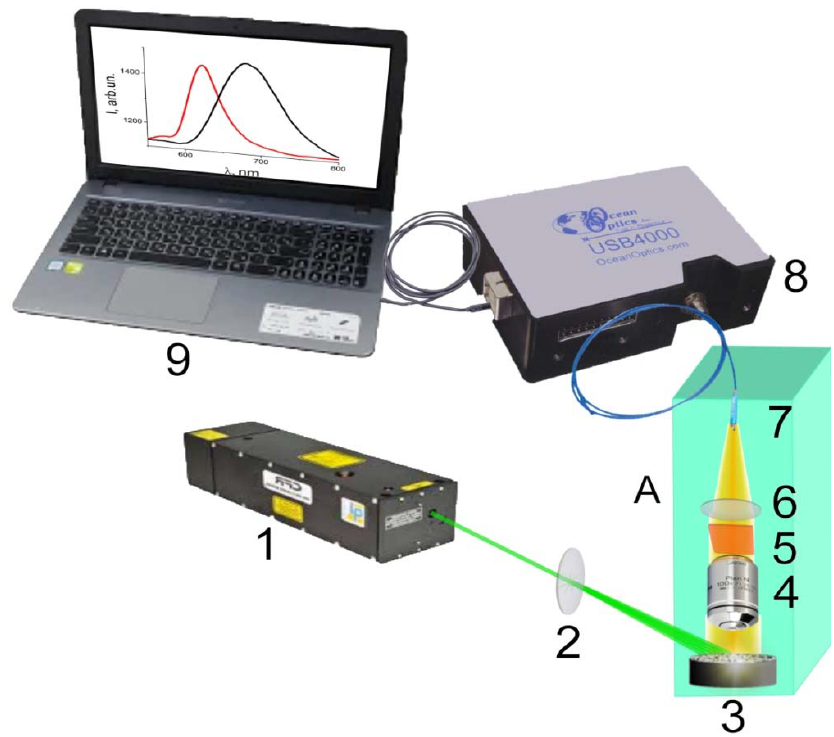
Figure 1. The scheme of the band-limited reference-free speckle spectroscopy (BLRFS) instrument used in this work: 1—a continuous wave (CW) pumping laser; 2—a concave lens; 3—a probed sample (a fluorescent dye-doped layer consisting of TiO2 or SiO2 nanoparticles); 4—a microscope objective; 5—a pump-blocking filter; 6—a light-collecting lens; 7—an input tip of the fiber-optic patch-cord as the entrance aperture; 8–a spectrometer; 9–a PC.“A” denotes a light-collecting unit (see Figure 2).